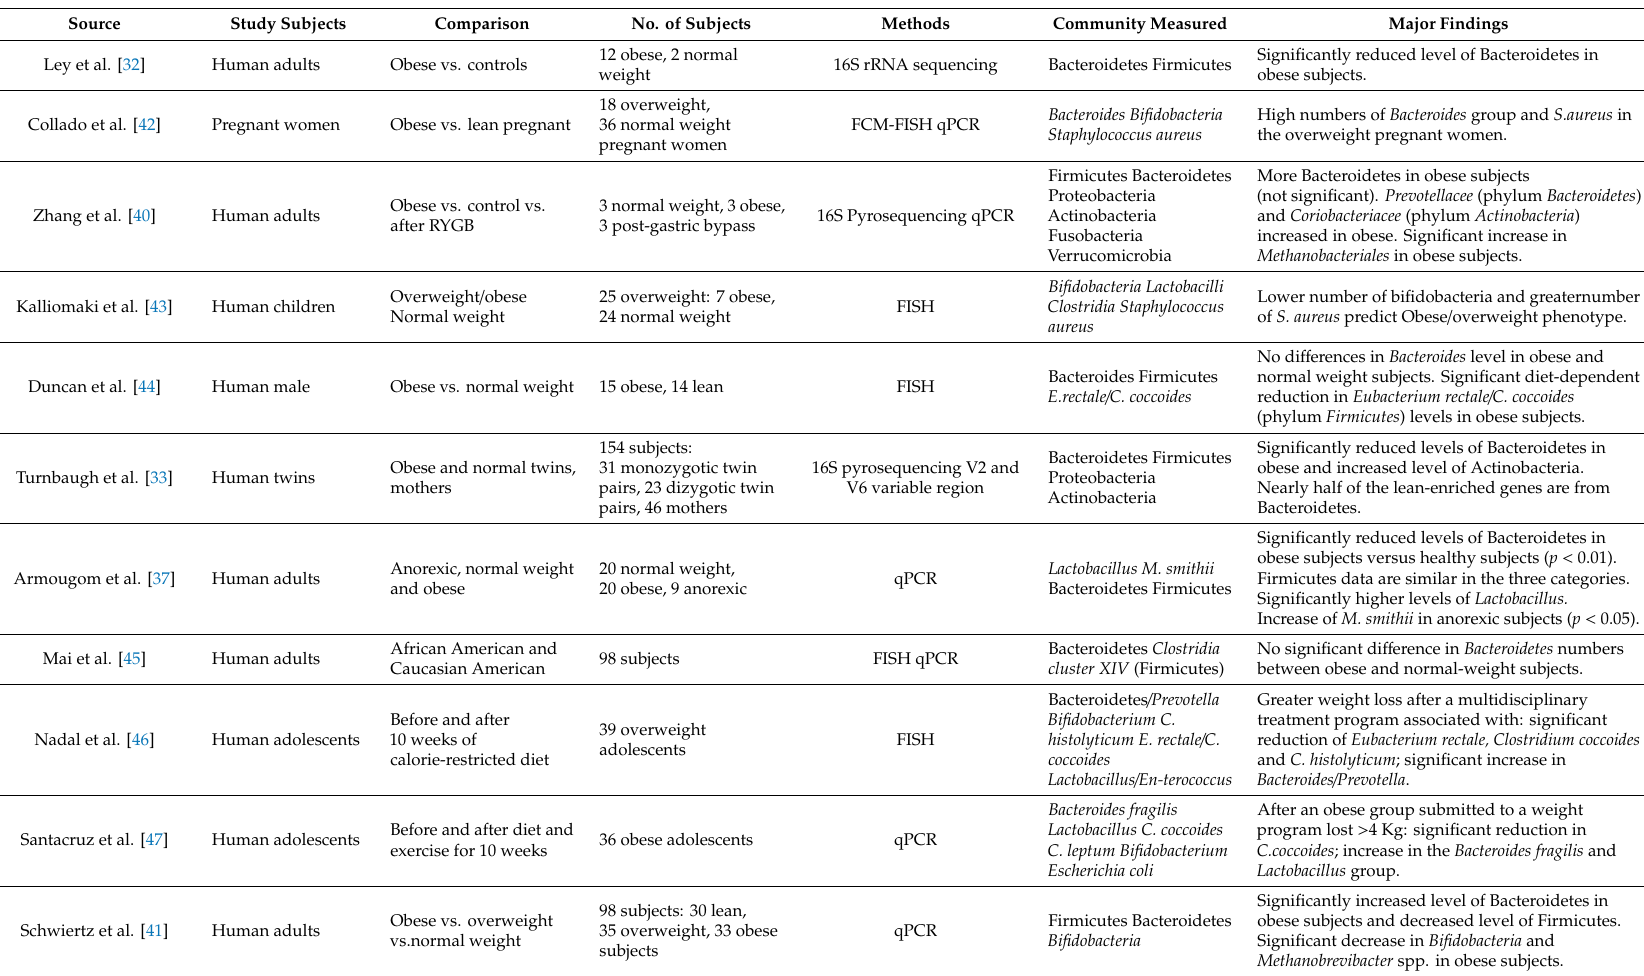
Table 2. Gut microbial population and obesity: relationship, causality and e ff ects in human